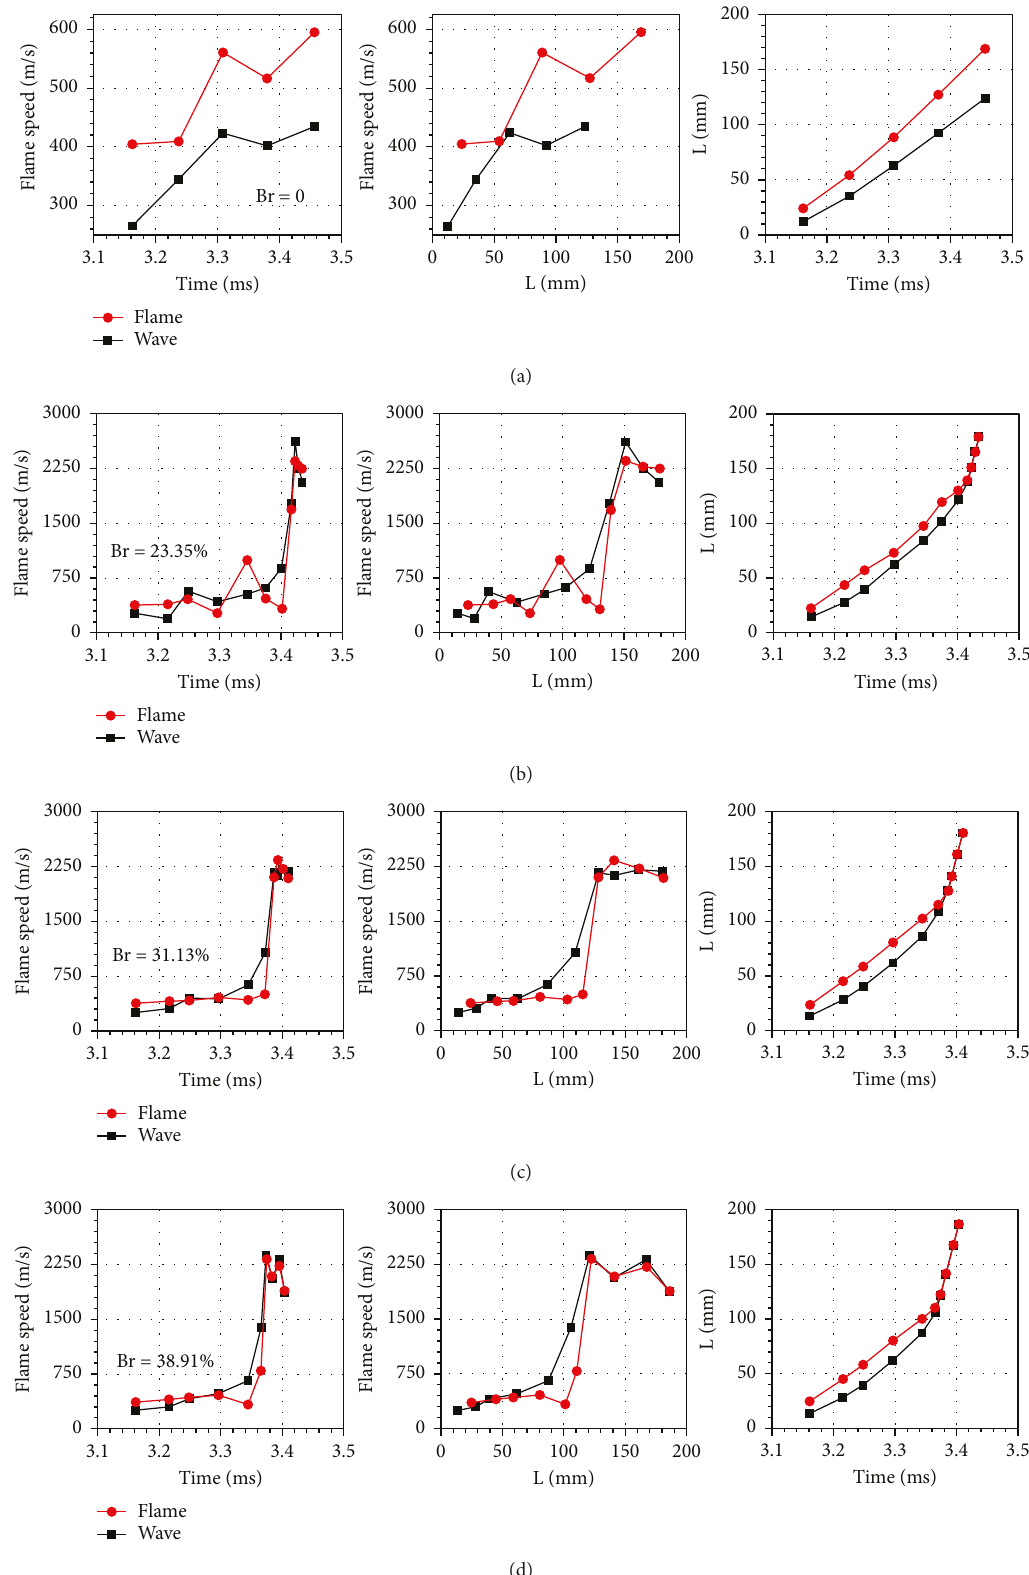
Figure 19: Propagation of shock wave and fl ames using spoilers with di ff erent blockage